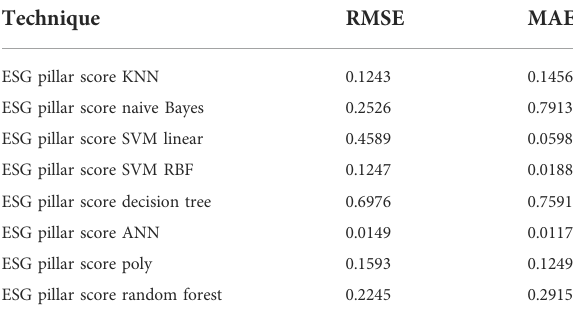
TABLE 11 Comparison of results based on RMSE and MAE of all the techniques used for predicting ESG pillar score. Technique